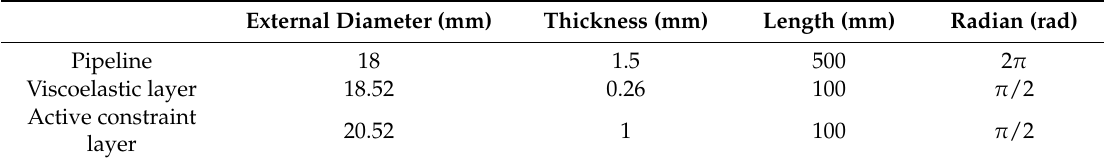
Table 1. Geometric parameters of the pipeline with ACLD patches.